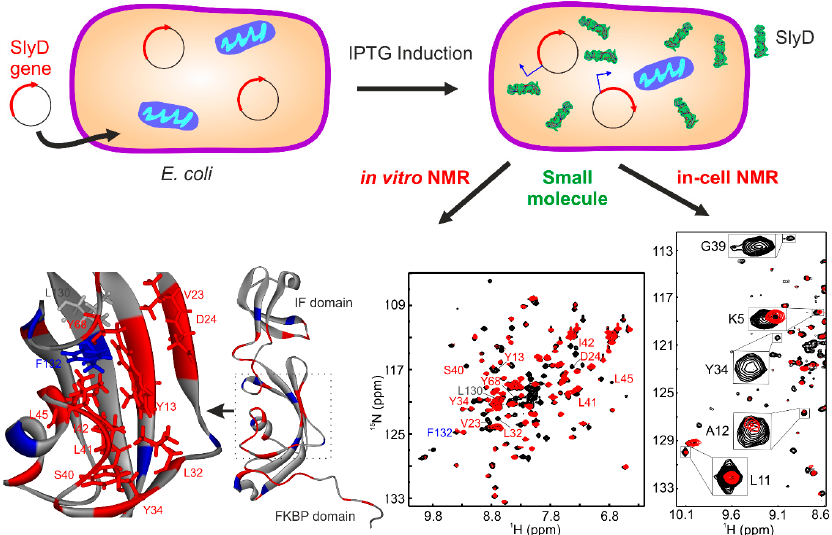
Figure 2. In-cell NMR study of protein–small molecule interactions. Here, a “sensitive to lysis” (SlyD)-containing plasmid was transformed into Escherichia coli and protein expression was initiated by isopropyl β - D -1-thiogalactopyranoside (IPTG) induction. These cells were further incubated with a small molecule (Cu 2+ complex). The interaction of this small molecule with SlyD could be observed using in-cell NMR, and correlated with corresponding in vitro NMR studies, revealing the binding site in SlyD for this Cu 2+ complex (adopted according to Reference [4]). Complete bacterial growth can be inhibited with a small molecule (anthracenyl terpyridine Cu 2+ complex) at 2 µM [4]. In order to evaluate the role of SlyD in bacterial growth, we transformed E. coli with the plasmid containing the SlyD gene, which is under the control of T7 promoter. The expression of the SlyD gene can, thus, be initiated by isopropyl β - D -1-thiogalactopyranoside (IPTG). Overexpressed SlyD could restore bacterial growth, confirming that SlyD is involved in growth inhibition induced by the Cu 2+ complex. This small molecule binds to SlyD with a dissociation